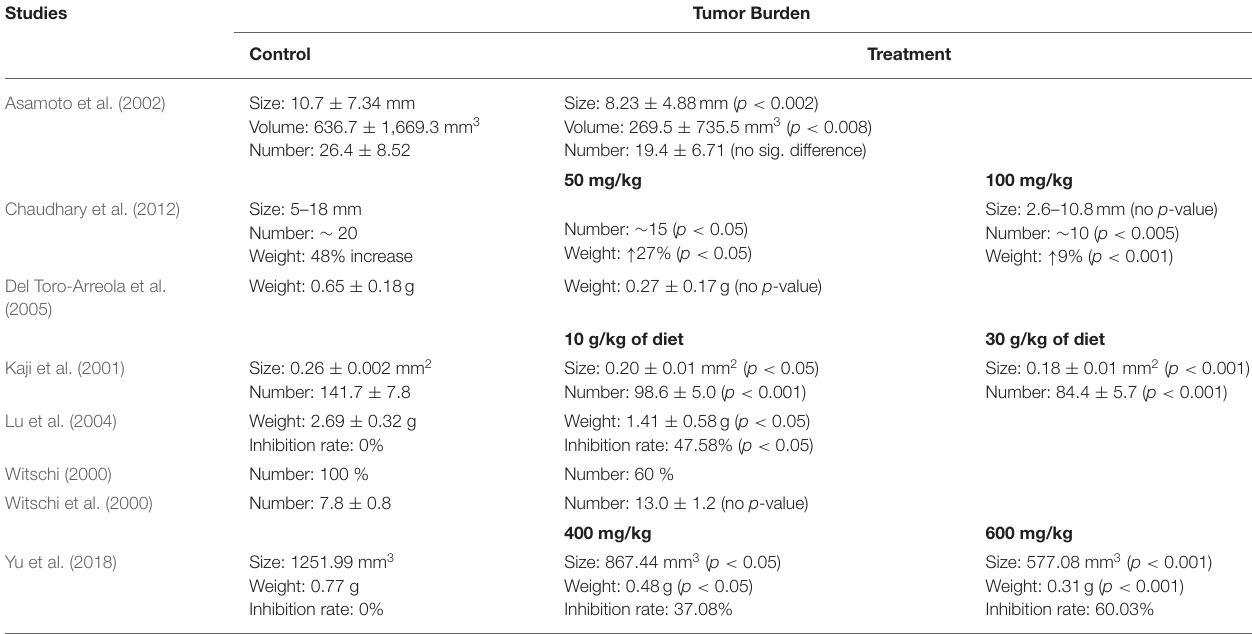
TABLE 3 | Effects of limonene intervention on tumor burden. Studies Tumor